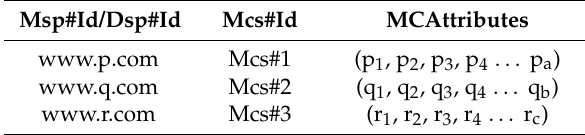
Table 3. MSP’s/DSP’s Mashup Configuration Service